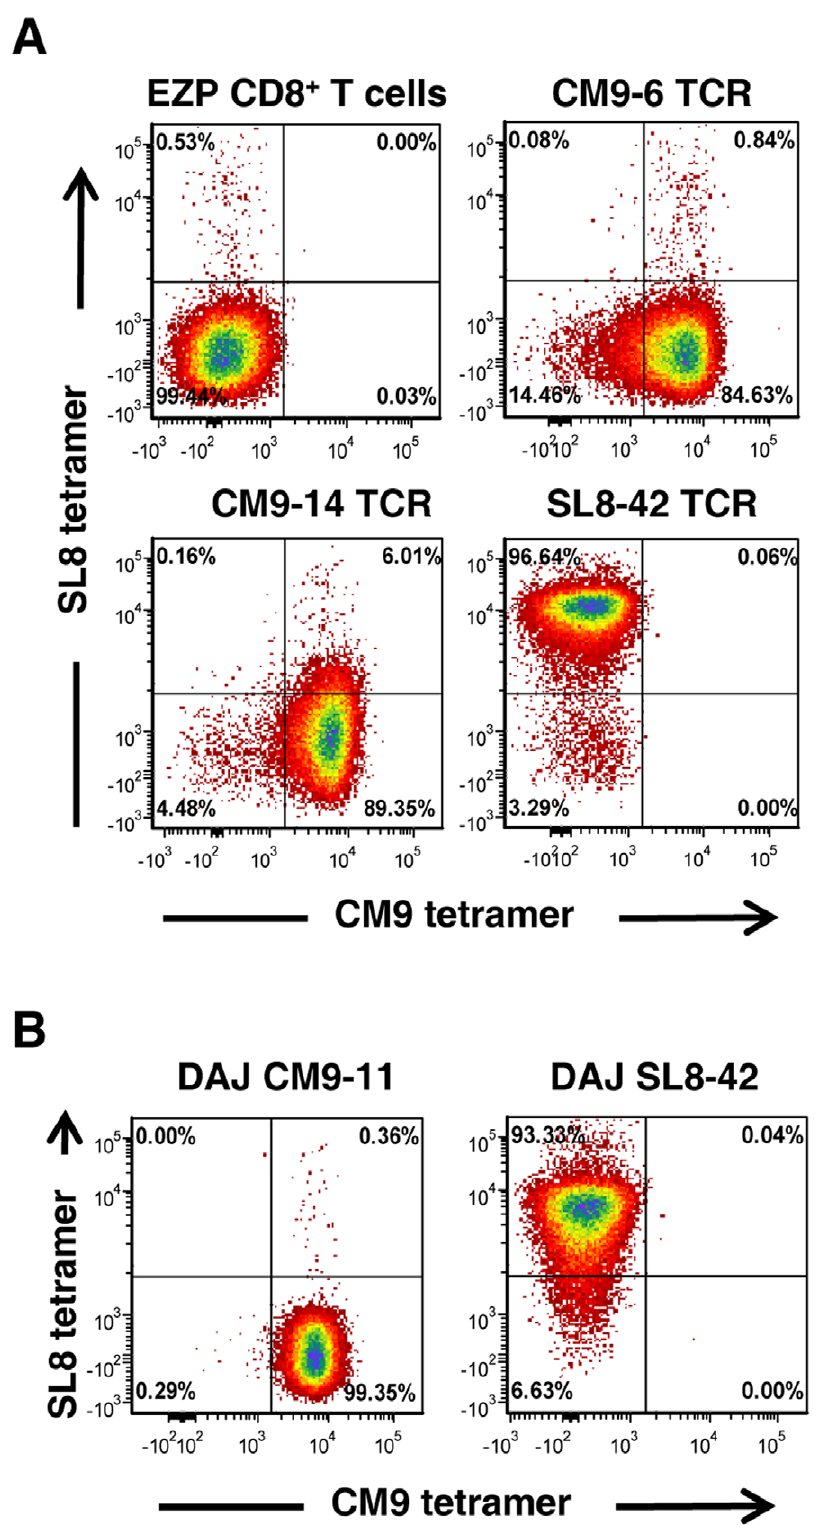
Figure 2. Flow cytometry analysis of transduced T cells. A, analysis of the TCR-transduced EZP cell lines for CM9 peptide/MHC tetramer and SL8 peptide/MHC tetramer is presented with that of the untransduced CD8 + control cell line from recipient animal EZP. B, tetramer analysis of two SIV-specific CTL clones isolated from donor animal DAJ is presented above tetramer-sorted TCR transduced CD8 + cell lines. The DAJ SL8–42 clone is the TCR gene donor for the SL8–42 TCR EZP cell line.